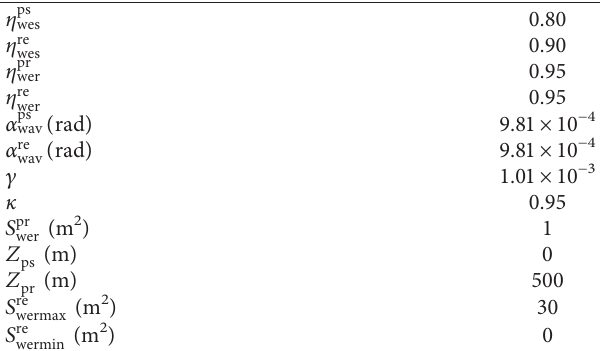
Figure 4: The position of the receiving node in the 10 times of optimization. Table 1: Experimental equipment